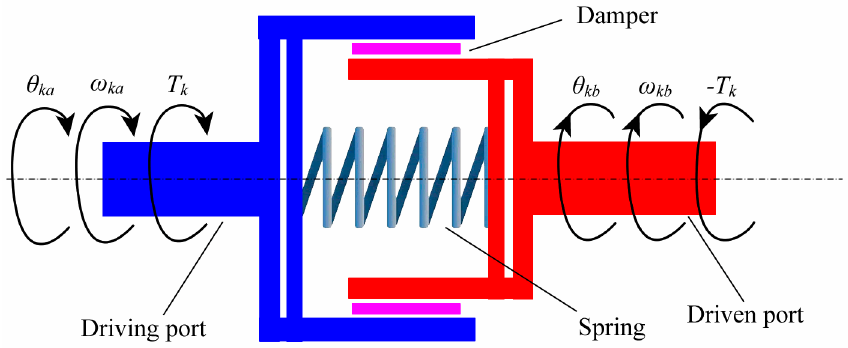
Figure 5. Schematic diagram of the spring-damper model.